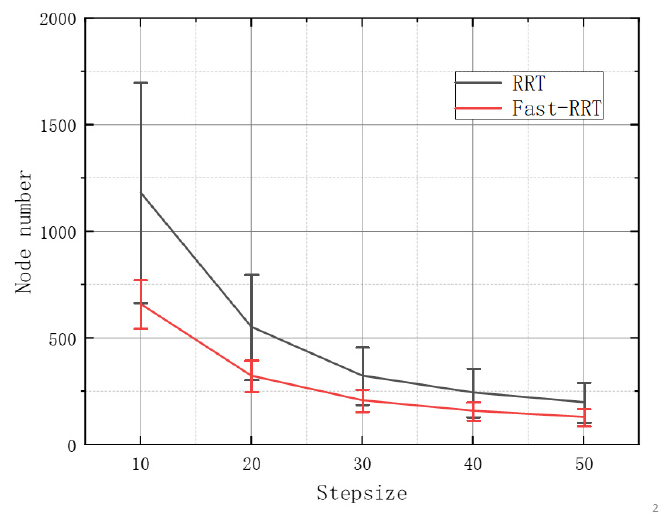
Figure 13. Comparison of the node number of the random tree in the Fast-RRT algorithm and the RRT algorithm with different step sizes.